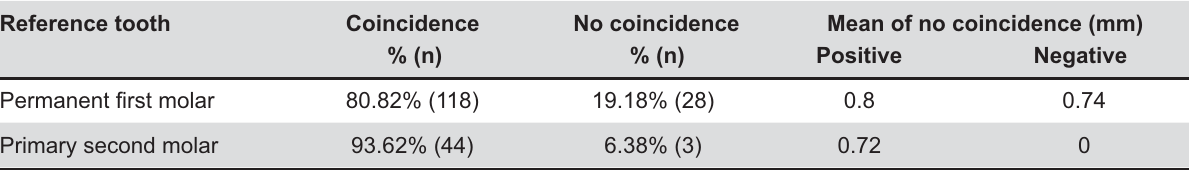
Left Side The same reference points were used, yet changing the sides.